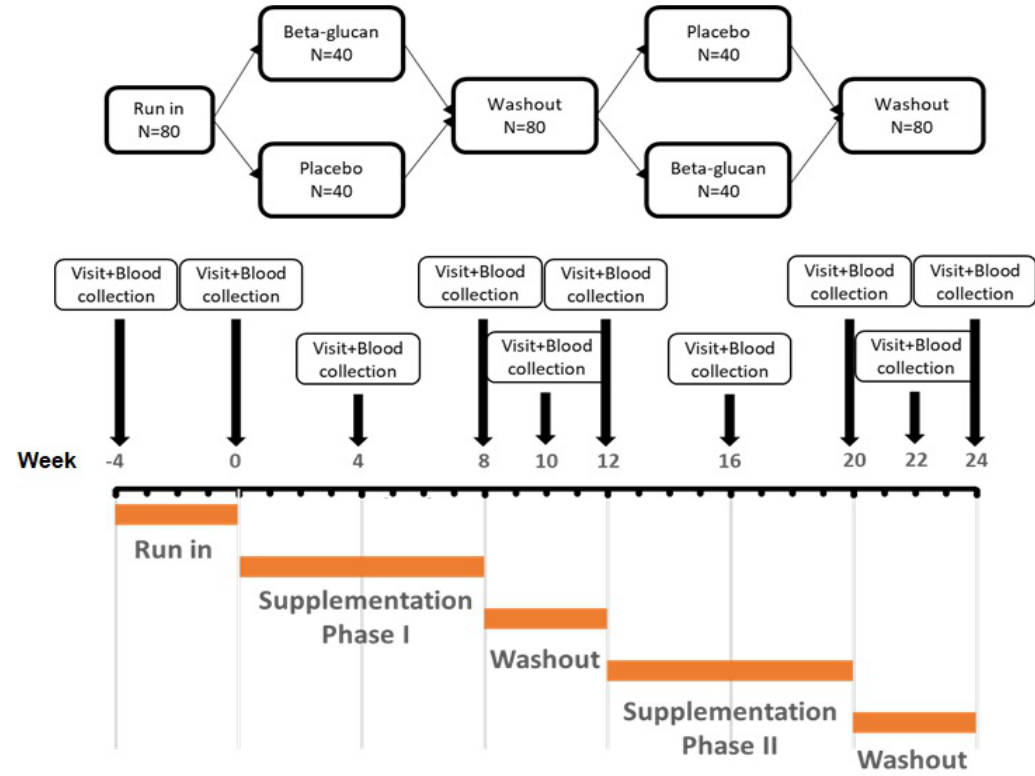
Figure 1. The flow-chart summarizes the study timeline.